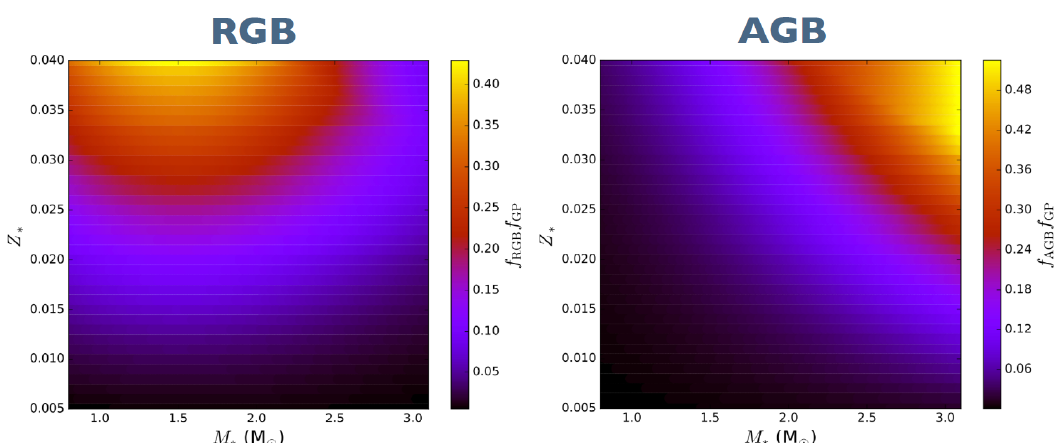
Figure 2. Probability of a star both having and engulfing a massive planet on the RGB or AGB as a function of host star mass and metallicity, according to synthetic planet population models created for varying metallicity. The trend is for engulfment probability to rise with metallicity and for engulfment to be more likely to occur on the AGB for more massive host star. Table 2. The resulting PN progenitor population proportions when adopting the probabilities of engulfment according to the known exoplanets evolved with five different metallicity stellar models. Z ∗ f planet f binary f other f NS f NS ( Pl ) 0.005